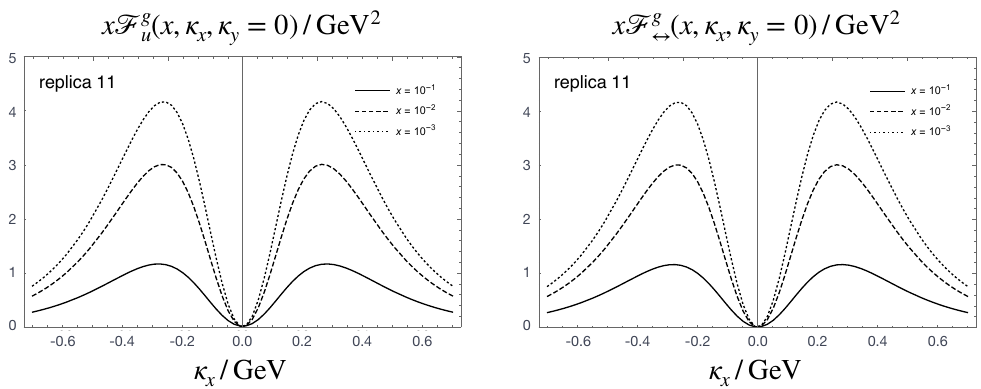
Figure 1. 3D tomographic reconstruction of the unpolarized ( left ) and Boer–Mulders ( right ) gluon TMD distributions in the proton, as functions of the gluon transverse momentum, at the initial energy scale, µ 0 = 1.64 GeV, and for x = 10 − 3 . Plots refer to replica 11 .